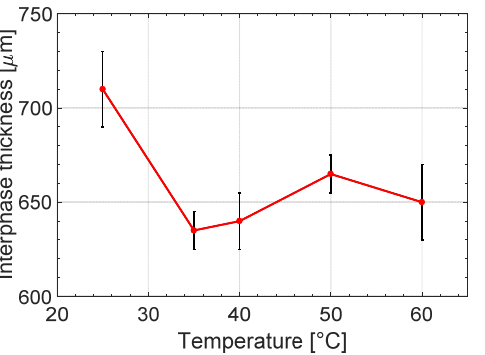
Figure 8. Interphase thickness formation between ABS and UPR for different processing tempera- tures.